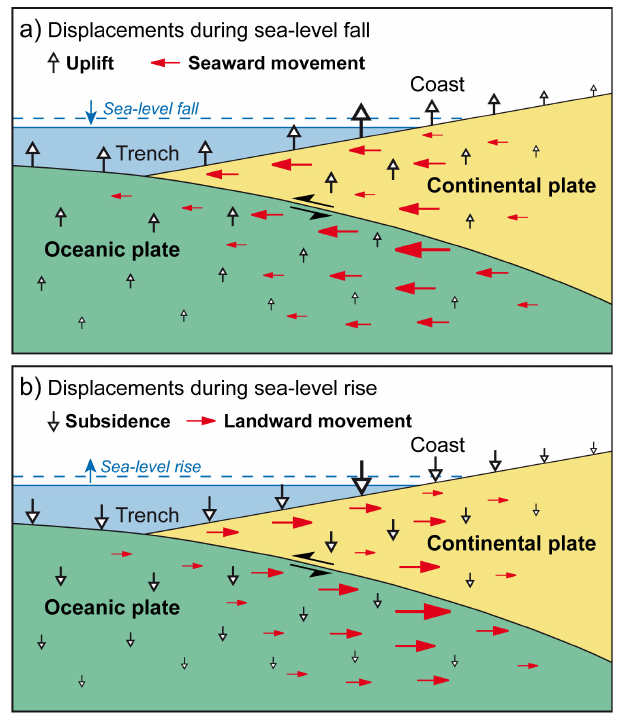
Fig. 5. Sketch summarizing the vertical and horizontal displace- ments resulting from (a) a falling sea level and (b) a rising sea level (not to